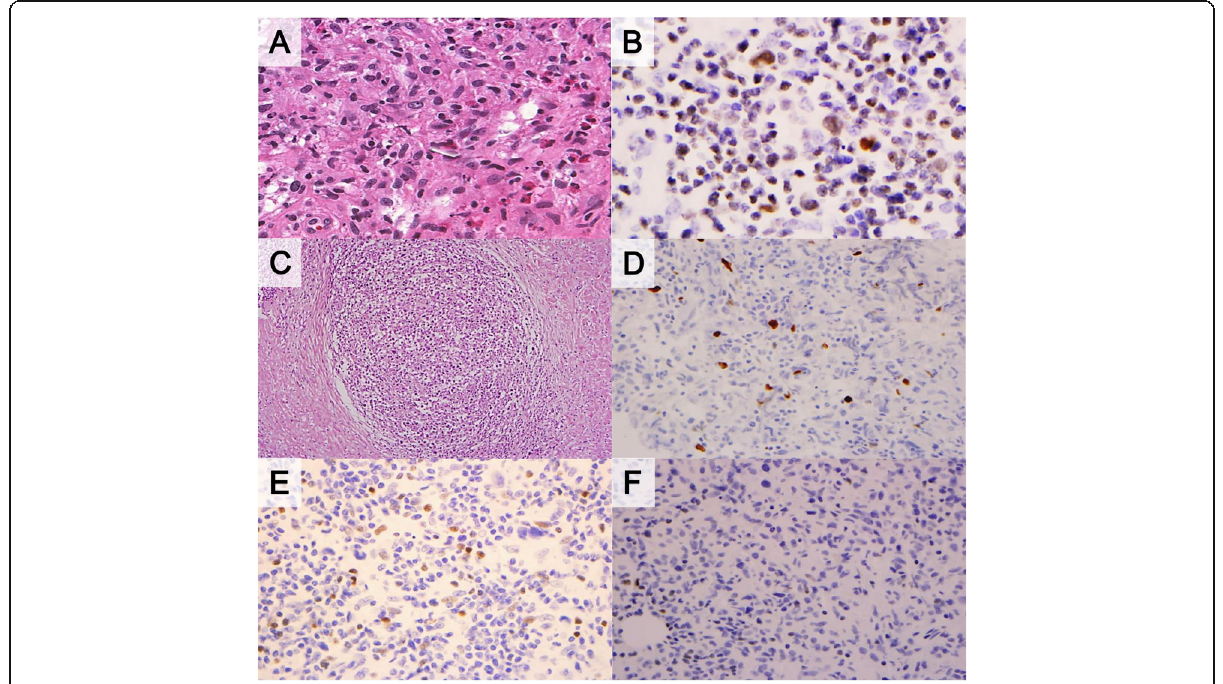
Fig. 3 Classic Hodgkin lymphoma ( a ) showed significantly higher positivity for GATA3 ( b ). A case of gray zone lymphoma showed nodular fibrosis ( c ), focal positivity for MUM1 ( d ), p63 ( e ) and negativity for GATA3 ( f